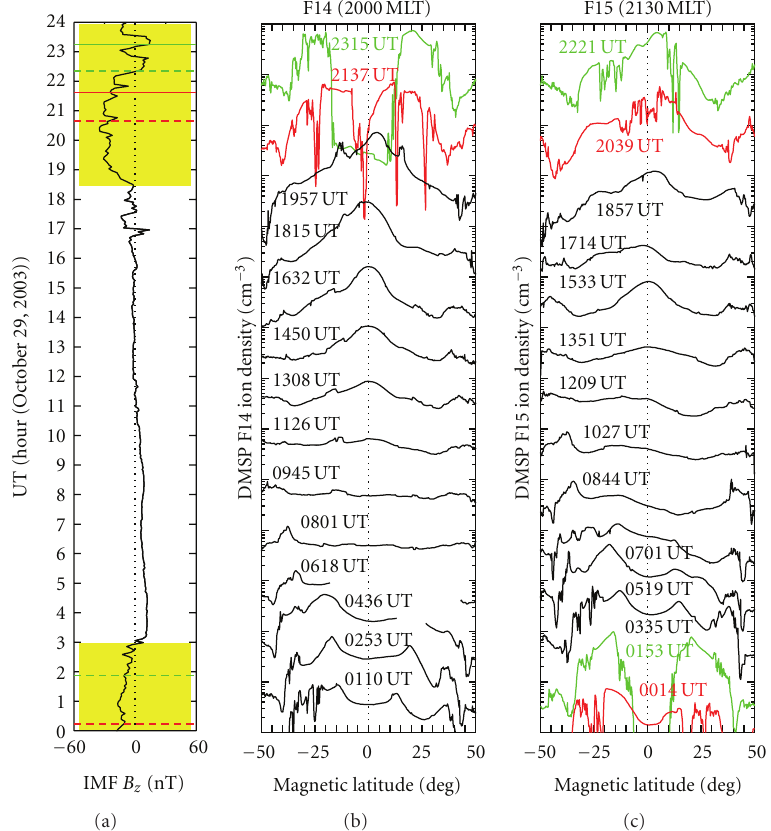
Figure 3: Occurrence of equatorial plasma bubbles during the periods of southward IMF on 30 October 2003. Figures 3(a)–3(c) show the IMF B z and the ionospheric ion density measured by the DMSP F14 and F15 satellites,